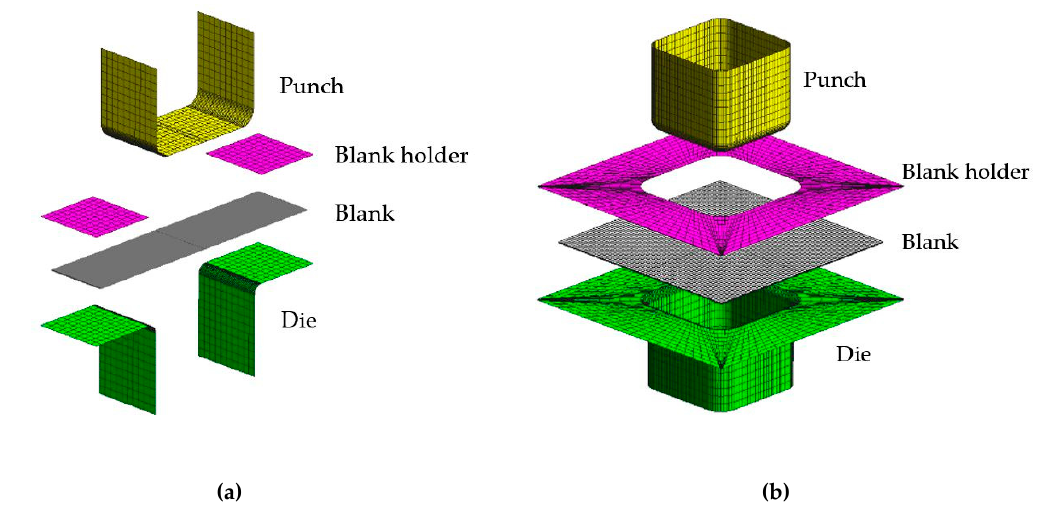
Figure 1. Representation of the finite element models for the ( a ) U-Channel; ( b ) Square